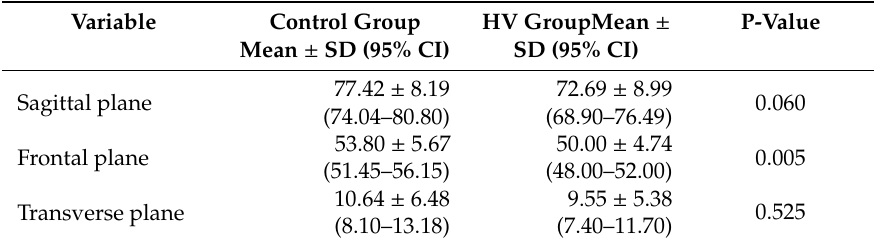
Table 2. Initial position of the first metatarsal head. The values of the sagittal plane position are millimeters from tibial malleolus (point A) to point 1 (the intersesamoid crest). A higher value implies a less dorsiflexed position (more distance between the tibial malleolus and the intersesamoid crest), and vice versa. The values of the frontal plane are degrees between a horizontal line and a line joining points 1 (the intersesamoid crest) and 2 (the superomedial tubercle). A higher value means a more inverted position (a higher angle between the line connecting points 1 and 2, and a horizontal line), and vice versa. The values of the transverse plane are millimeters from point 1 to a vertical line crossing point A (a positive value means that the point 1 was located within the tibial side of the vertical line crossing point A, and vice